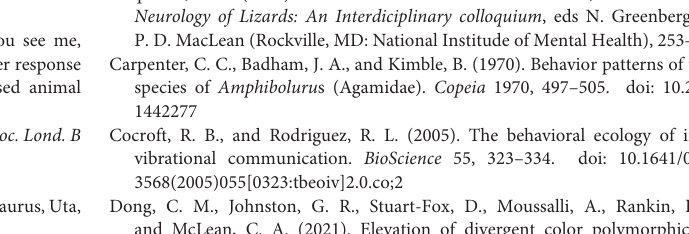
Supplementary Figure 1 | Schematic illustration of the recording of lizards and plants. Middle Panel: Focal (resident) male lizards were located in their natural habitat and two cameras were positioned nearby before a tethered intruder was introduced at a distance of 1 m from the focal lizard. The display response of the focal lizard was filmed with both cameras. After filming was completed and the focal lizard had departed, the scene was mapped to identify the relative position of plants to the focal lizard. This includes all plants surrounding the focal lizard (a full 360 o rather than the limited set of four plants A–D shown here). Left Panel: Display movements were digitized separately from the footage of both cameras and subsequently combined to yield 3D positions over time, with the change in position between successive frames yielding measures of speed. Right Panel: The response of plants to standardized wind speed generated by a leaf blower was filmed and subsequently analyzed using motion detector algorithms. The analytical process is explained further in the text and in Figure 2 . The rationale for, and full description of, our approach can be found in: Ramos and Peters (2017b). Quantifying Ecological Constraints on Motion Signaling. Frontiers in Ecology and Evolution